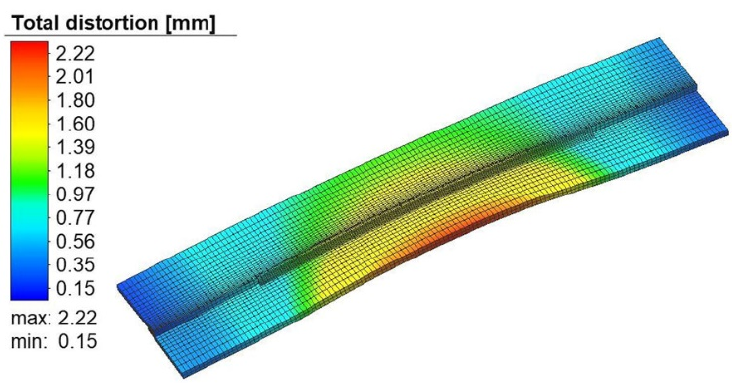
Figure 14. Distortion produced in random welding sequence.